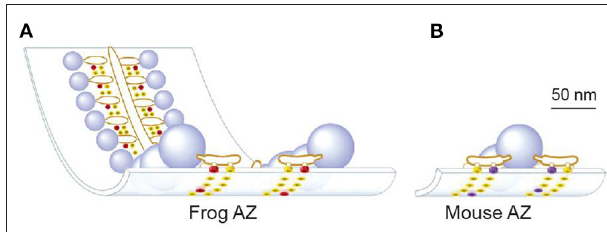
FIGURE 4 | Drawings based on electron microscope tomography data of single active zone structure from frog (A) and mouse (B) neuromuscular junctions. Light blue spheres = docked synaptic vesicles; yellow dots represent AZ transmembrane proteins of unknown identity; red dots represent